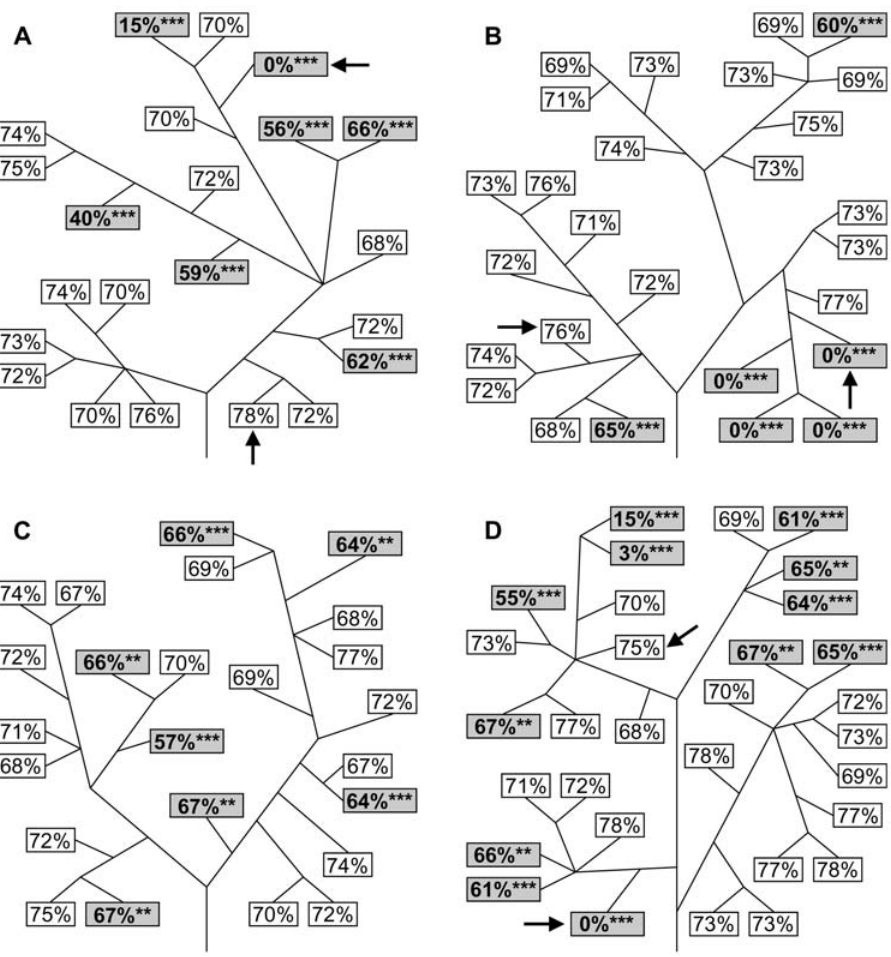
Figure 1. Instability of kanamycin resistance. The percentages of kanamycin resistant progeny from a number of self-fertilised seed capsules are shown for kr2.3 (A), kr2.5 (B), kr2.7 (C) and kr2.10 (D). Each box represents a seed capsule, with the percentage of kanamycin resistant progeny from that capsule shown. Approximately 200–250 seeds from each capsule were tested for kanamycin resistance. Lines represent branches (not to scale) and are included to show the branching pattern of the plants from which individual seed capsules were progeny tested. Seed capsules that deviate significantly ( P , 0.01) from the expected 75% kanamycin resistant progeny are highlighted with grey shading. Arrows indicate seed capsules which were used for PCR and DNA blot analysis (see Figures 3 and 4). ** P , 0.01, *** P , 0.001. ing (Figure 2). Consistent with results for the initial kr plants (Figure 1), the kr2.7 line appears to be more stable than kr2.3 or